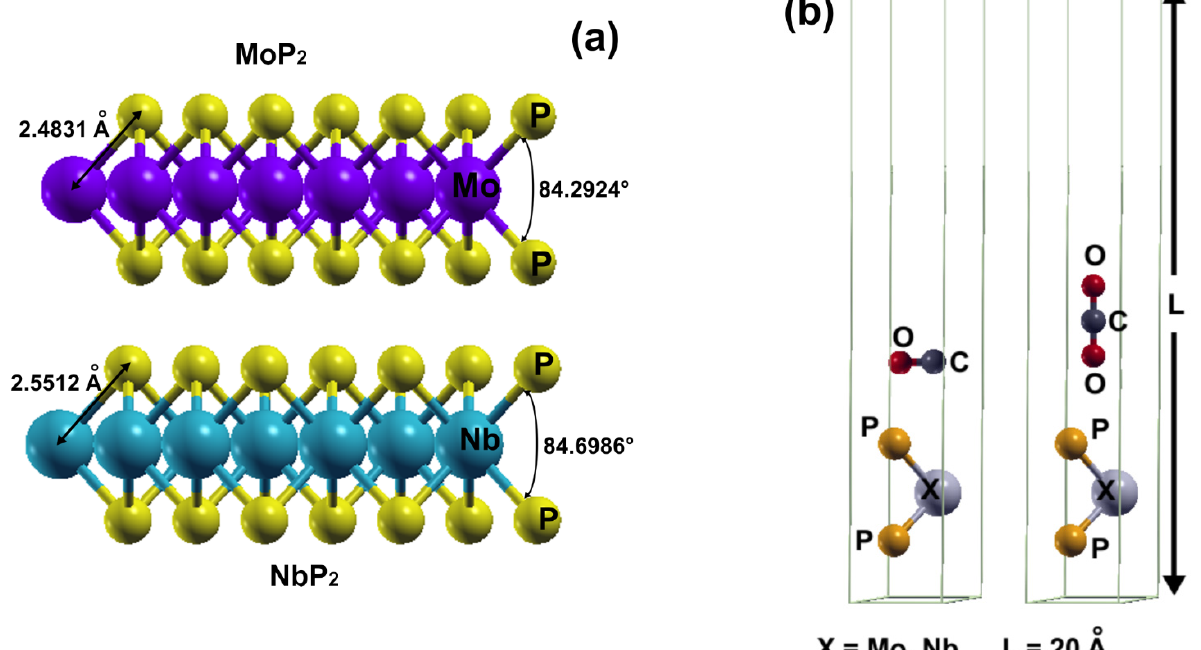
Figure 1. The characteristics of the 2D materials we studied after optimization ( a ). In ( b ), we show the unit cells we considered before our FPMD simulations.